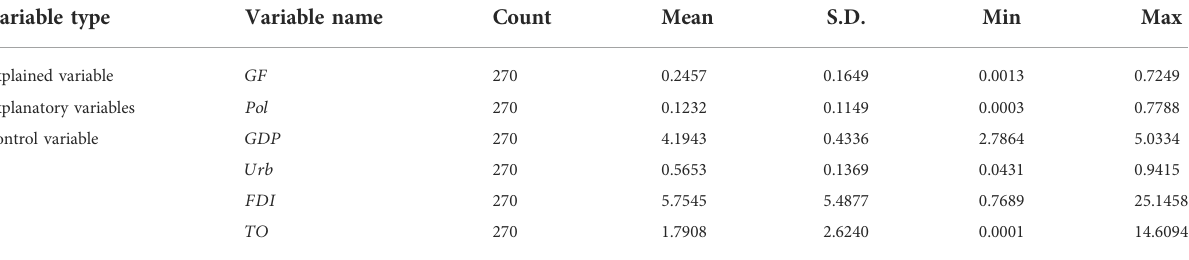
TABLE 3 Variable descriptive statistics results.